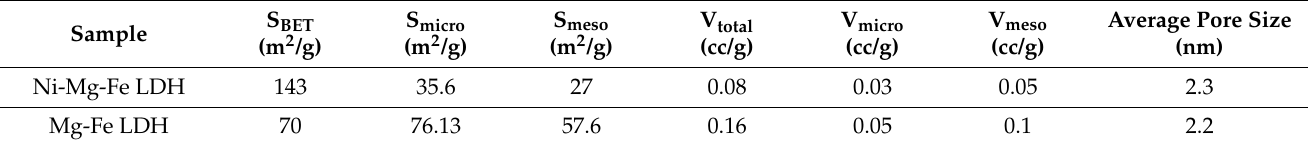
Figure 5. ( A ) N 2 adsorption–desorption isotherms; ( B ) pore size distribution curves for the Mg- Fe LDH and Ni-Mg-Fe LDH catalysts. Table 1. Textural properties of the di ff erent catalysts from N 2 - physisorption. Sample